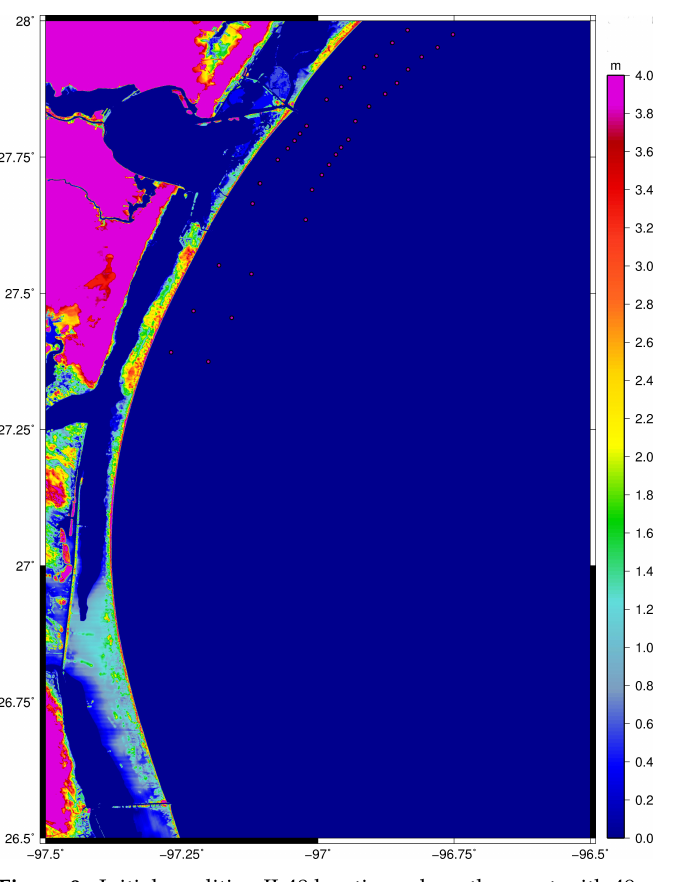
Figure 9. Initial condition II-48 locations along the coast with 49 particles each.